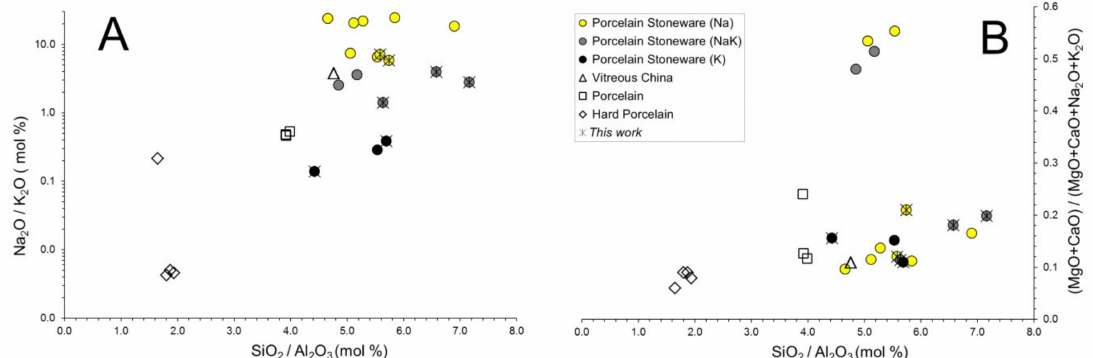
Figure 2. Chemical composition of porcelain stoneware bodies compared with other porcelain-like materials: silica/alumina ratio versus soda/potash ratio ( A ) and alkaline earth oxides to alkaline + alkaline earth oxides ratio (calculated on mol %) ( B